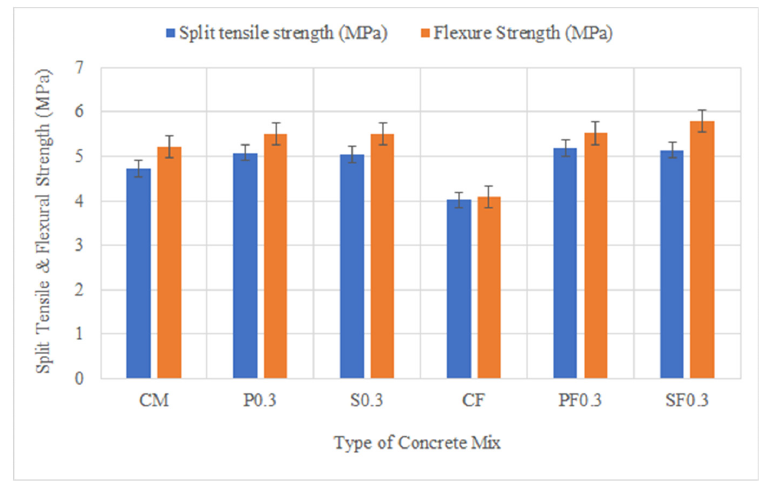
Figure 6. Split Tensile and Flexural strength of different concrete mixes measured at 28 days. Appl. Sci. 2021 , 11 , x FOR PEER REVIEW